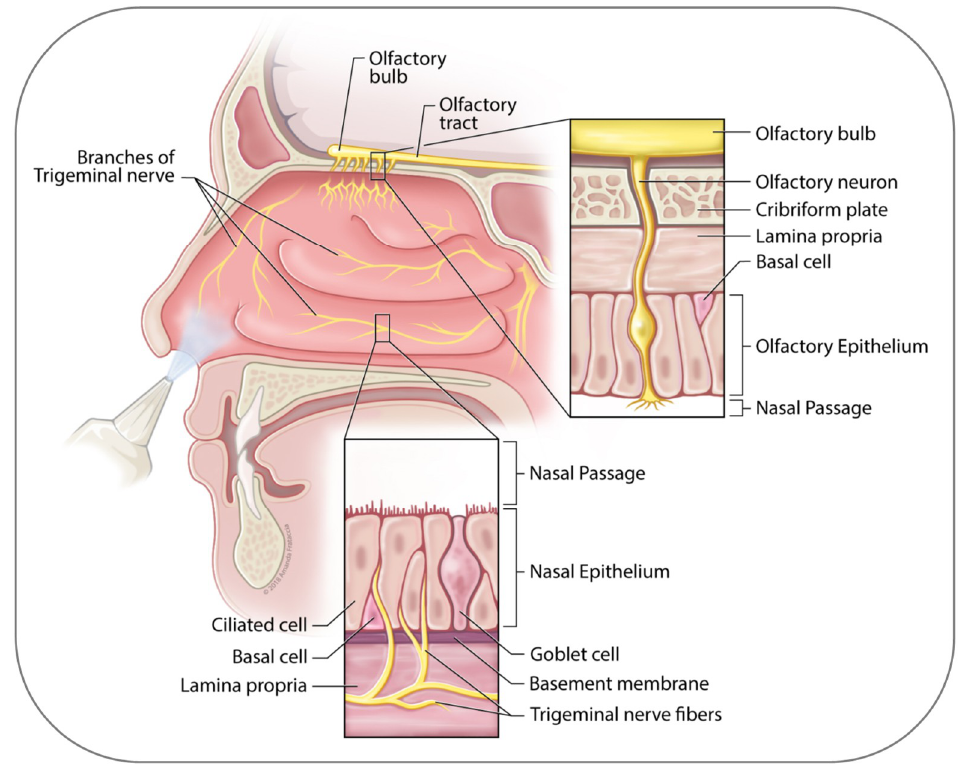
Figure 1. Lateral section of the human nose. Shown are key anatomical structures involved in drug transport from the nose to the brain. Location of olfactory and trigeminal nerves in yellow. Details of olfactory and respiratory epithelia in enlarged sections. See text for details. (Artwork by Amanda Frataccia; © 2018 Amanda Frataccia, provided under CC BY-NC-ND 4.0.).